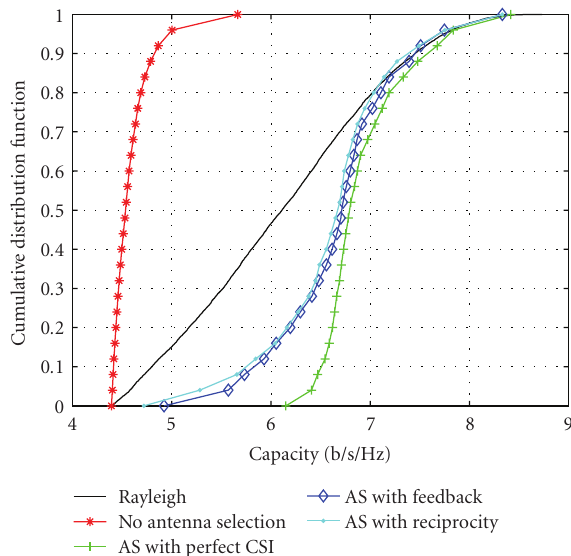
Figure 9: The cumulative distribution function of capacity at Location